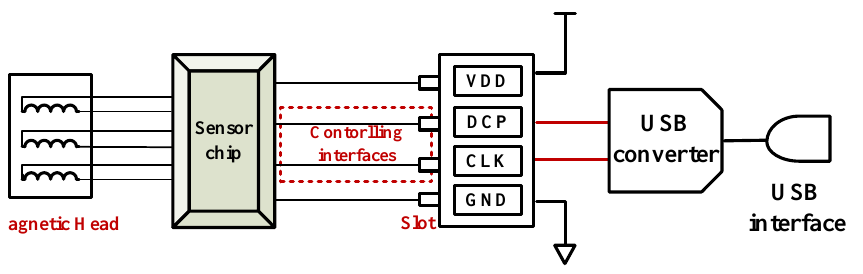
Figure 13. The block diagram of magnetic card swipe machine with USB’s interface.